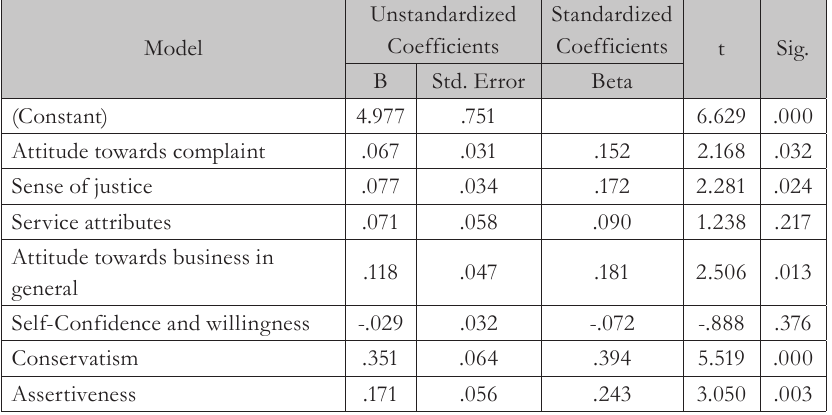
Tab. 7 - Influence of antecedent variables on Loyalty, Source: Researchers’ Computation, 2015